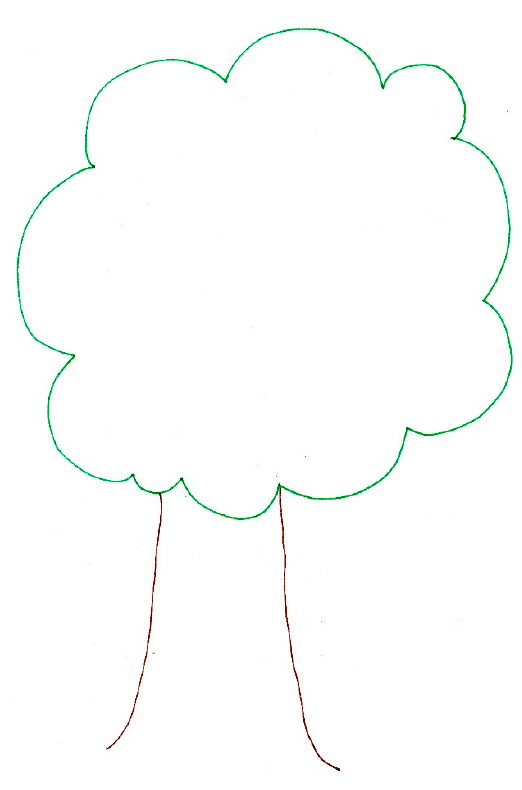
Figure 5. Mark’s Figure 5. Mark’s drawing.